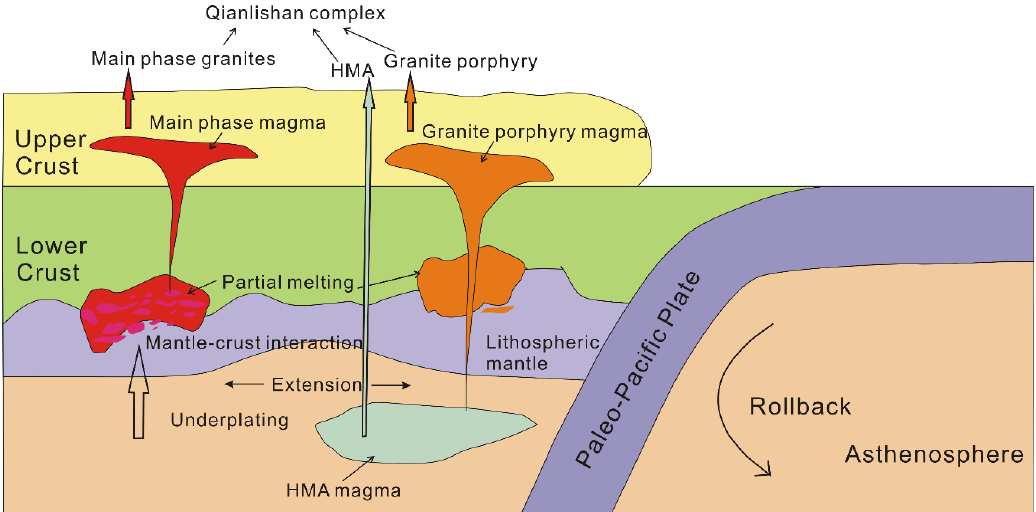
Figure 16. Schematic illustration of the petrogenetic mechanism of the Qianlishan high-Mg andesite (HMA) and Qianlishan granites.